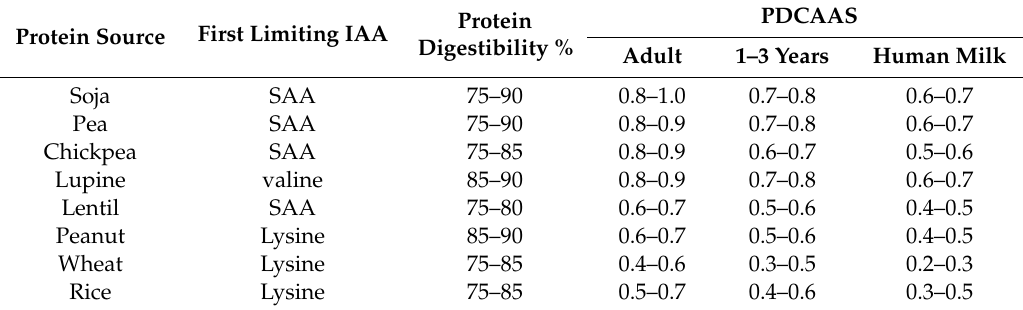
Table 2. Limiting IAA, protein digestibility and PDCAAS values of di ff erent plant protein sources, for adult and young children, or calculated from human milk